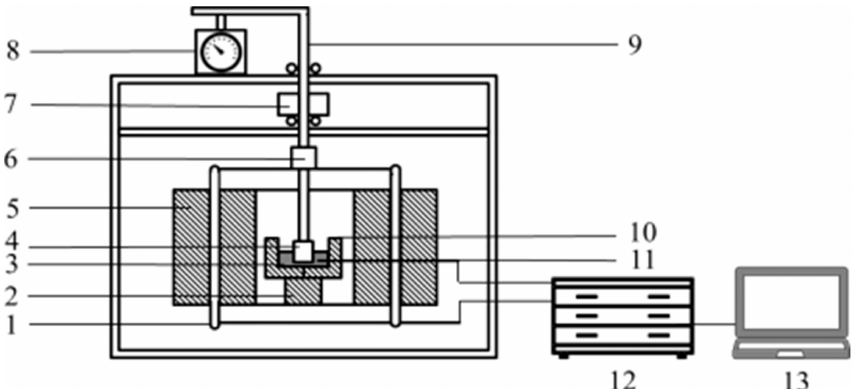
Figure 2. Schematic diagram of the softening properties experimental apparatus. 1—Si-C heater; 2—shell; 3—Al 2 O 3 pedestal; 4—sample; 5—Si-C bar; 6—fastening screws; 7—load; 8—meter; 9—steel